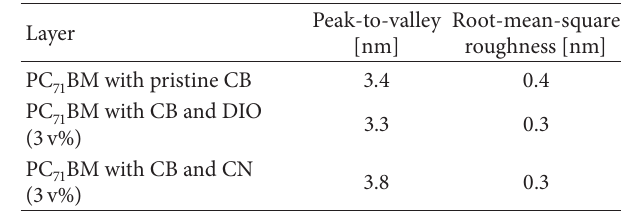
Table 2: Surface roughness parameters of the PTB7 thin films obtained from AFM analysis.